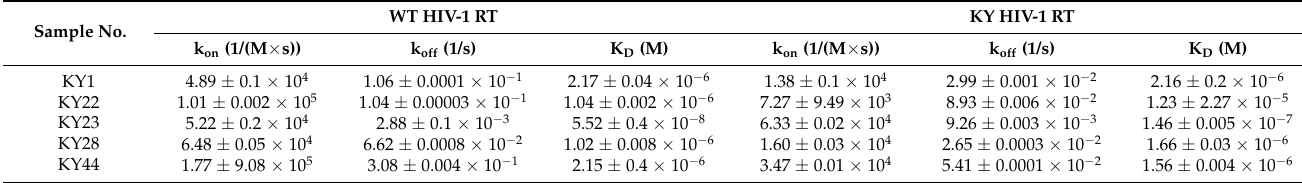
Table 2. Binding affinity of HIV-1 RTs-aptamer Table 1. IC50 values of synthesized KY DNA aptamers on HIV-1 RTs DNA polymerase function. Sample No.